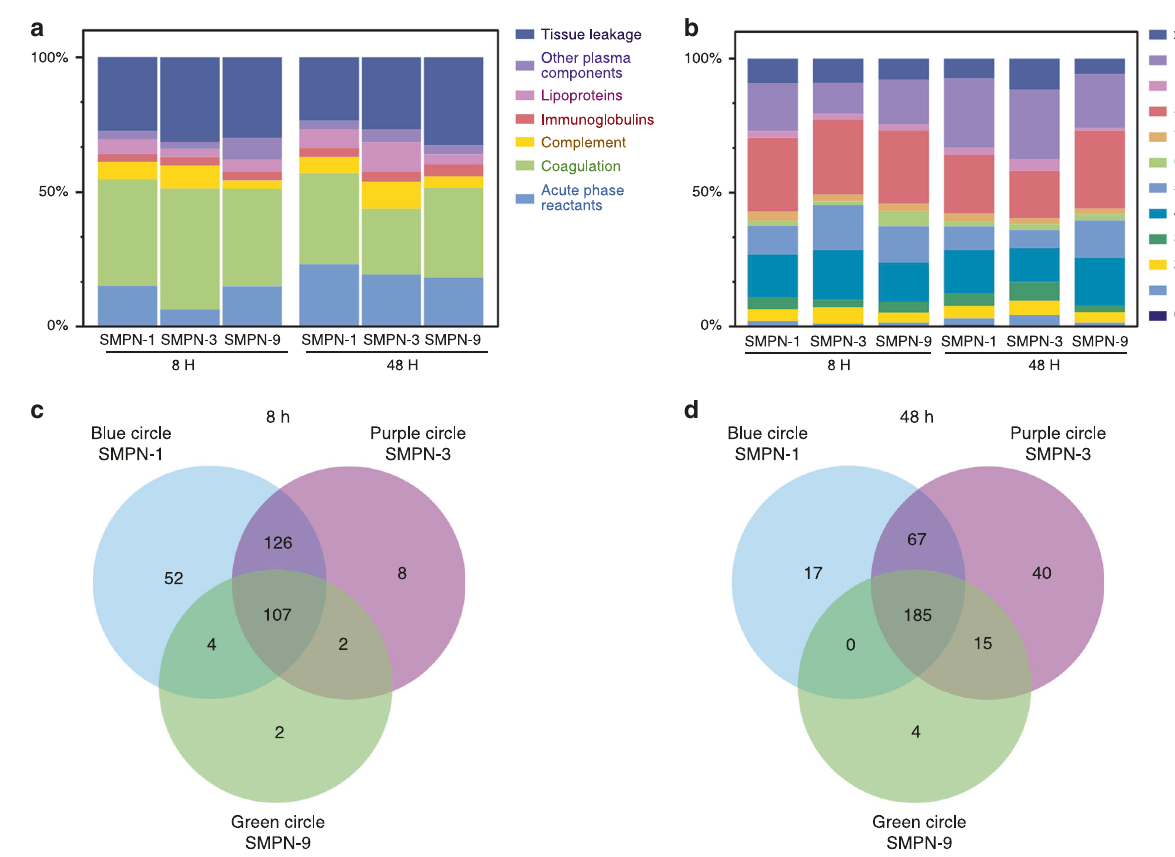
Fig. 4 Analysis of protein corona formed at the nano-biointerface of SMPN-1, -3, and -9. Adsorbed proteins on the surface of different SMPNs at 8 and 48 h post i.v. injection in mice ( n = 4) were determined. Abundance of each functional protein group as the percentage of total proteins on SMPNs with circulation time ( a ) and molecular weight ( b ). Unique proteins identi fi ed at the nano-biointerface of SMPNs with time on different SMPNs at 8 and 48 h post i.v. injection in mice. Venn diagrams depicting unique and common proteins identi fi ed on different SMPNs at c 8 h and d 48 h post-injection in